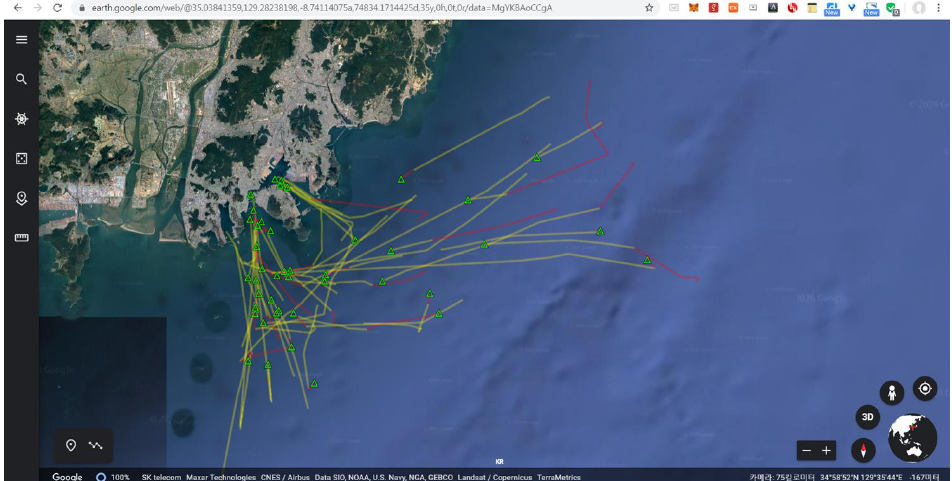
Figure 13. Visualization result of Fishing Activity Prediction on Google